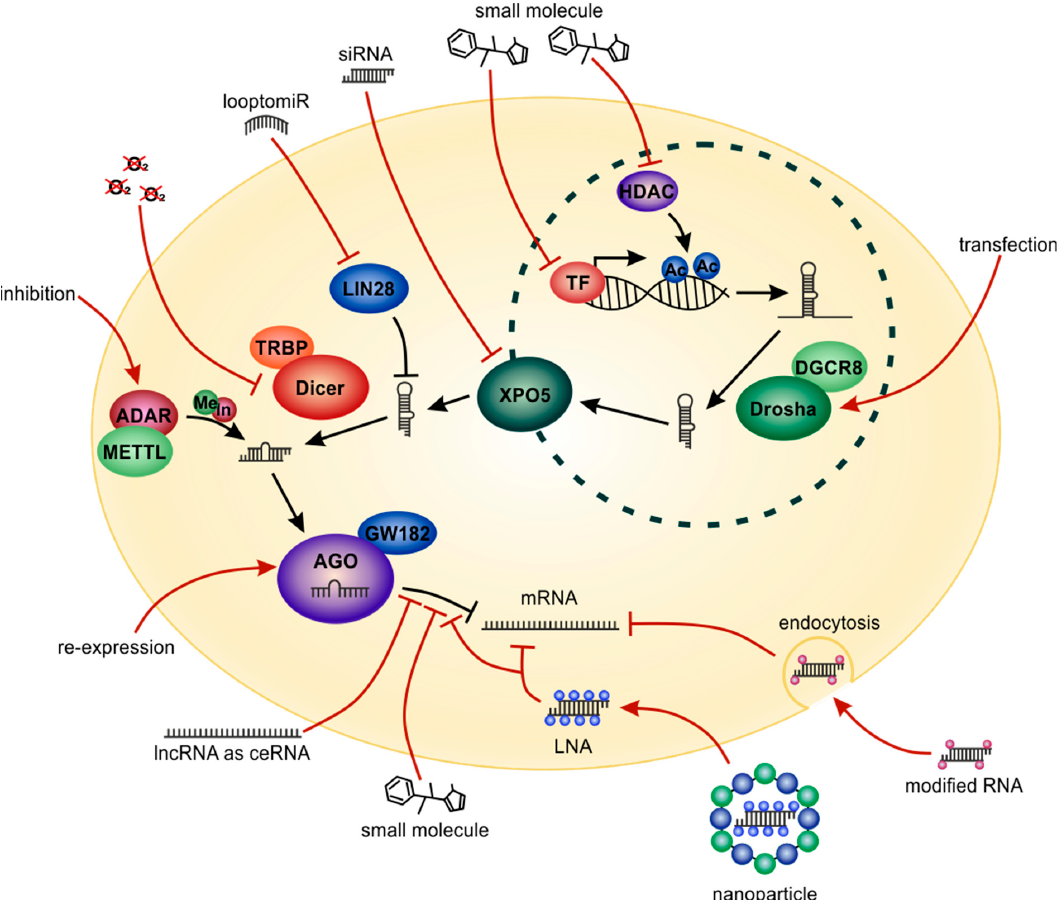
Figure 9. Potential ways to therapeutically target miRNAs and miRNA-related enzymes. Red arrows indicate multiple approaches for targeting miRNAs for therapeutic purposes. Small molecule